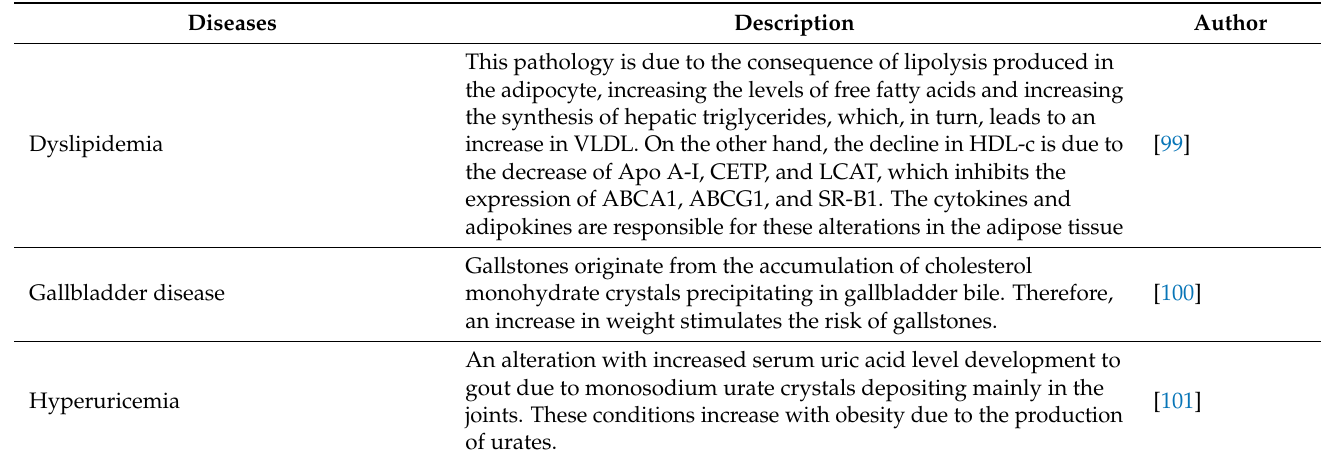
Table 2. Obesity and its relationship with other